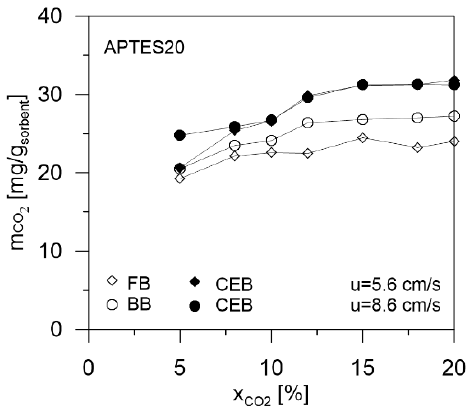
Figure 18. Mass of CO 2 adsorbed on adsorbent at increasing CO 2 concentrations for APTES20 at different contact modes and at two velocities.